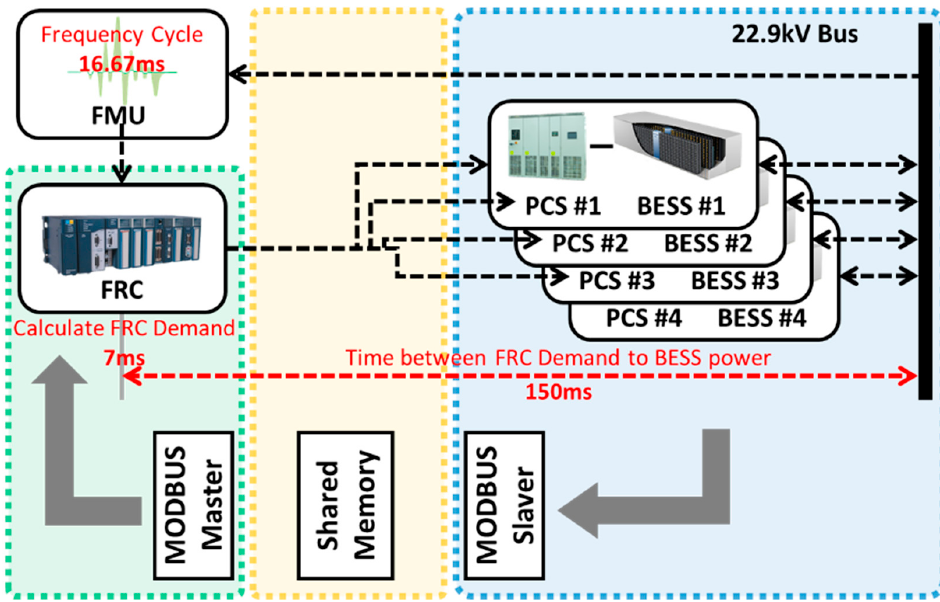
Figure 12. Configuration and characteristic of BESS System for actual and cyber physical system.